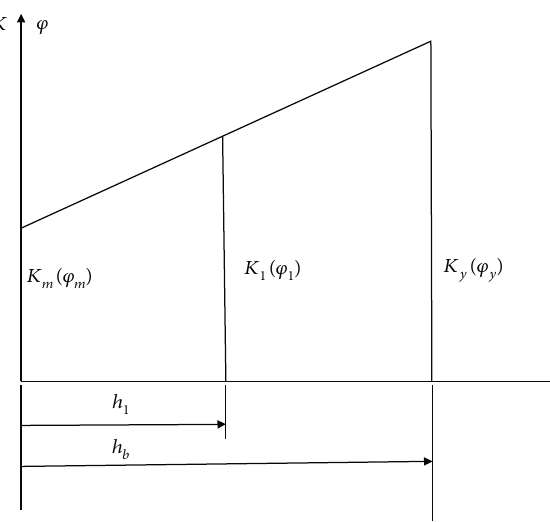
Figure 4: Parameter conversion relation of coal and rock